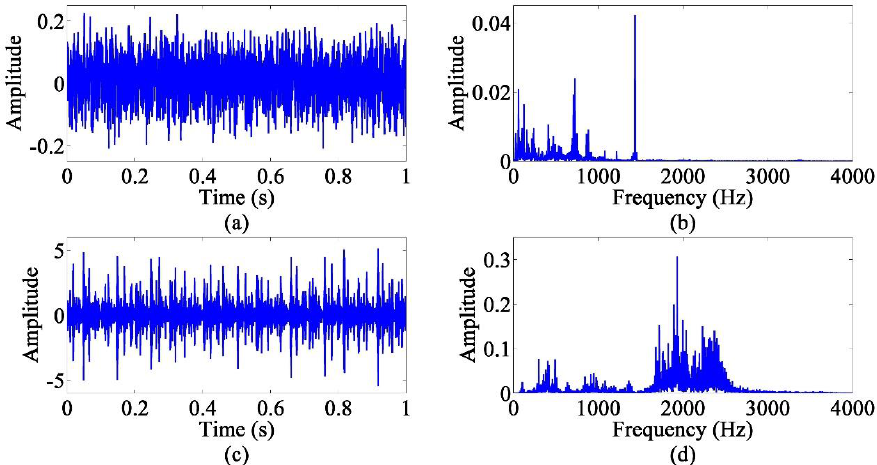
Figure 10. The time-domain waveform and amplitude spectra of a healthy signal and faulty